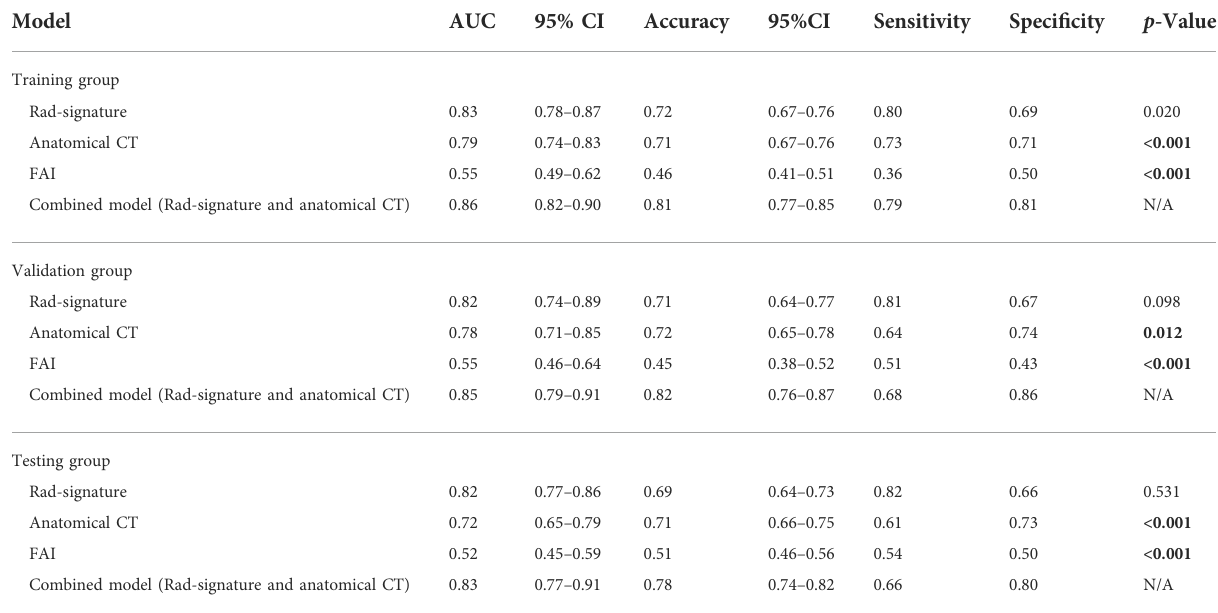
TABLE 3 Performance metrics of all models at the vessel